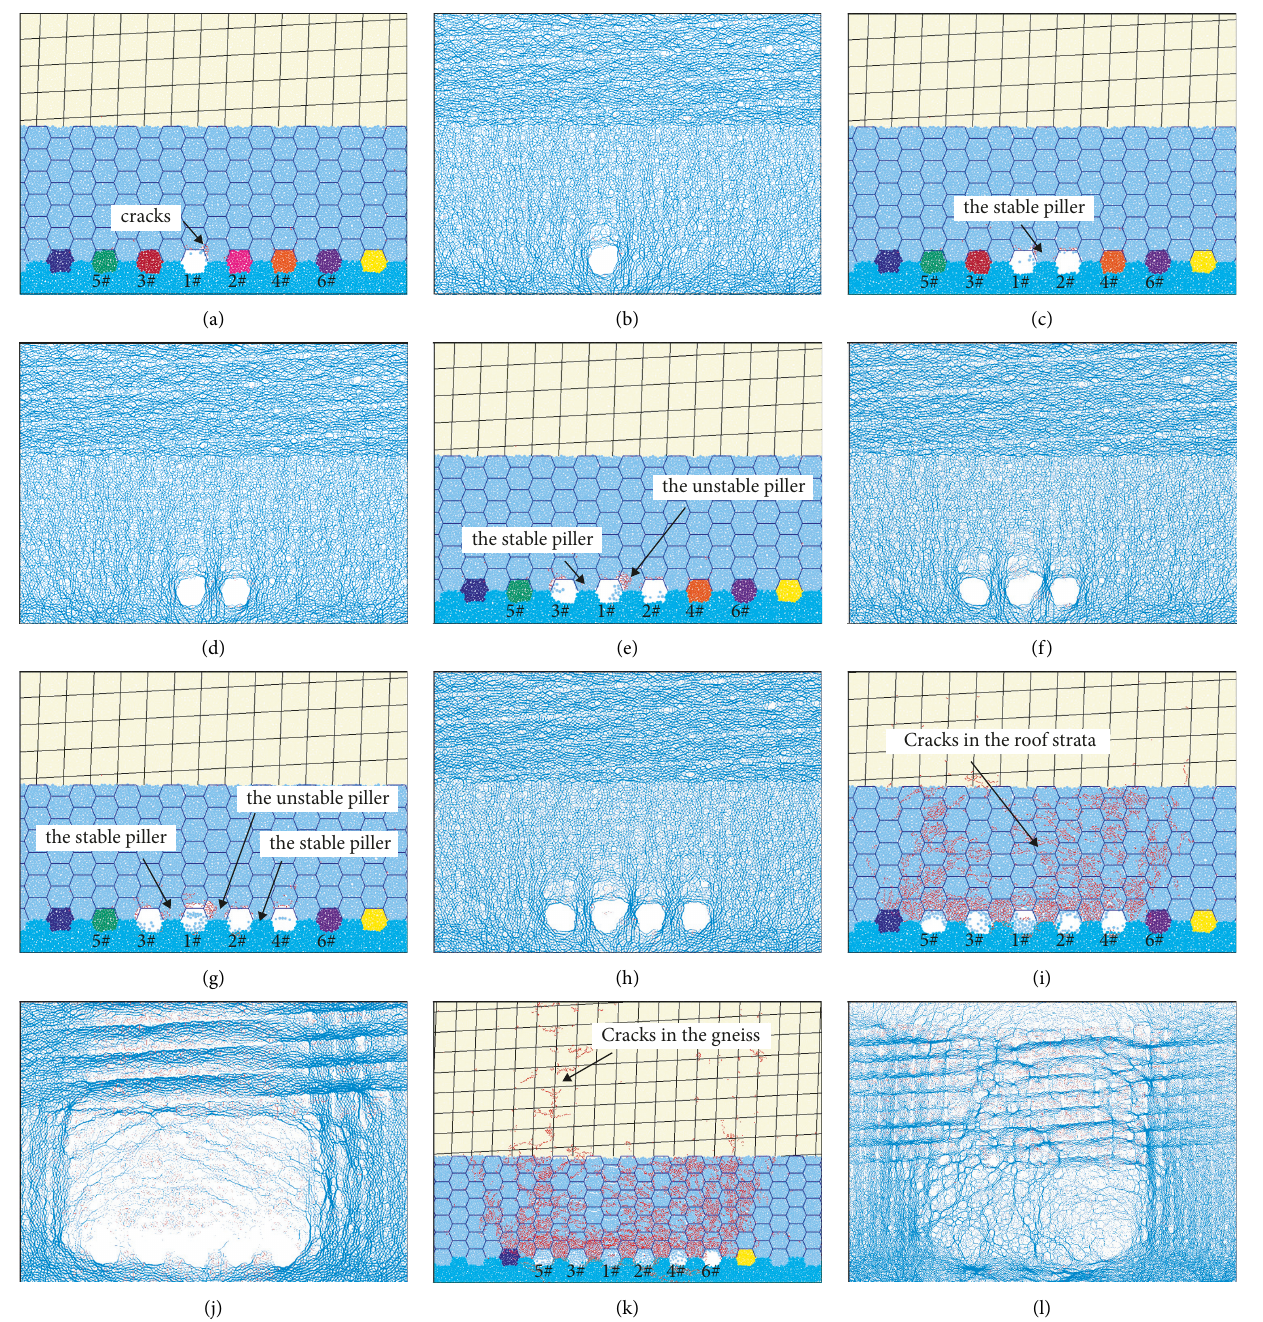
Figure 16: Illustrations of instability process of the pillars and roof. Left: The failure and fracture development of the model. Right: The contact force chain of the model (blue represents pressure and red represents tension). (a)–(b) The 1 # drift is excavated; (c)–(d) The 2 # drift is excavated; (e)–(f) The 3 # drift is excavated; (g)–(h) The 4 # drift is excavated; (i)–(j) The 5 # drift is excavated; (k)–(l) The 6# drift is